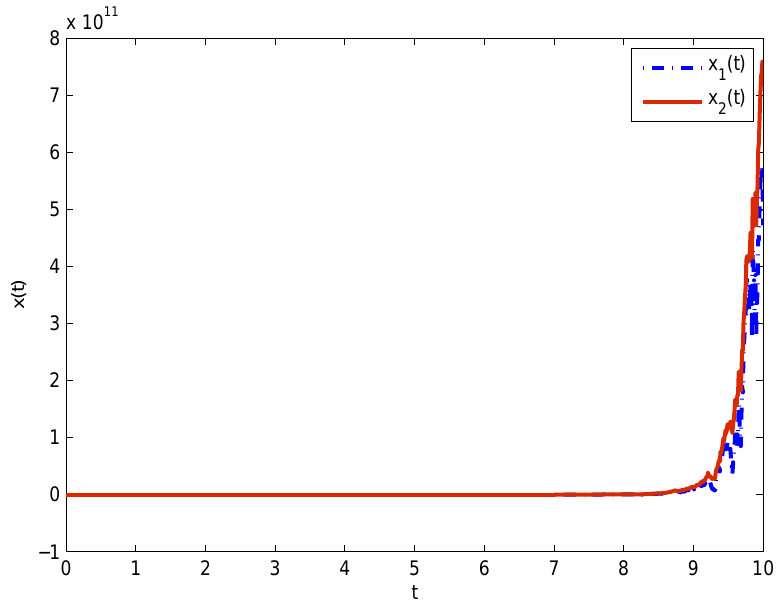
Figure 2. State trajectories of the open-loop